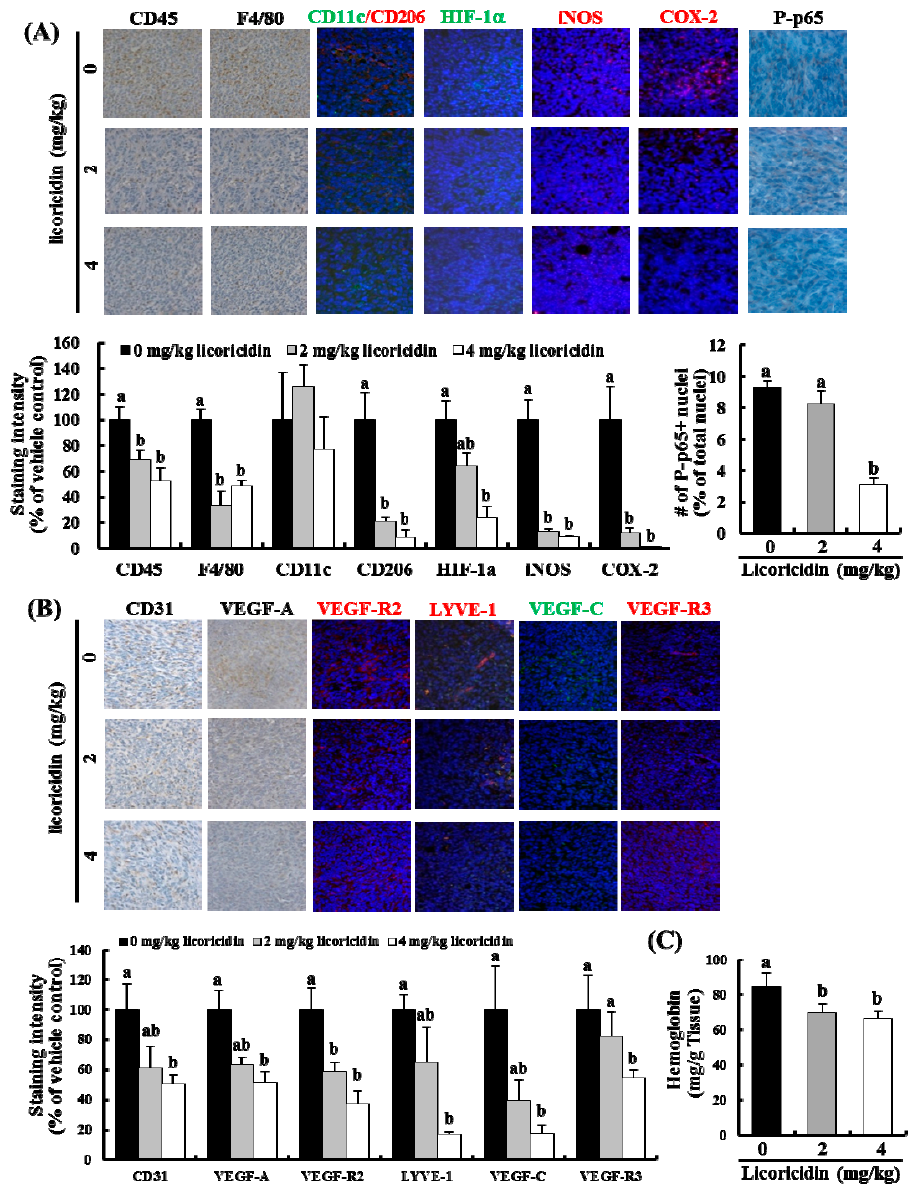
Figure 4. Licoricidin decreases the expression of proteins related to inflammation, angiogenesis, and lymphangiogenesis in 4T1 mammary tumor tissues of BALB/c mice. Tumor sections were stained with antibodies against ( A ) CD45, F4/80, CD206, CD11c, HIF-1 α , iNOS, COX-2, and P-p65 or ( B ) CD31, VEGF-A, VEGF-R2, LYVE-1, VEGF-C, and VEGF-R3, and counterstained with H&E or DAPI. Representative immunohistochemical or immunofluorescence images are shown ( upper panel). Staining intensity was quantified ( lower panel). Each bar represents the mean ± SEM ( n = 5); ( C ) Hemoglobin concentrations in tumor tissues. Means without a common letter differ among the tumor cell-injected groups, p <